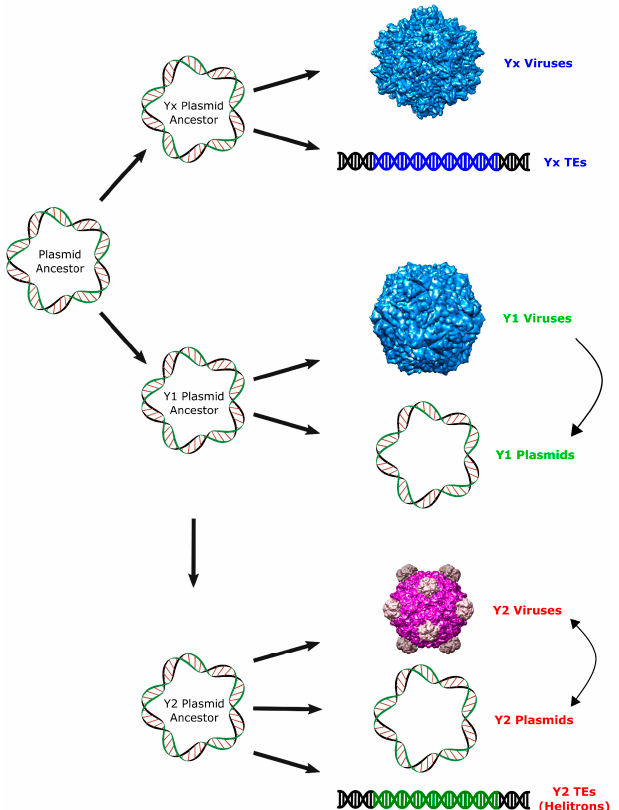
Figure 4. Proposed scenario for the origin of Helitrons and other RCR elements. Arrows represent putative pathways to explain the observed relationship among RCR elements. Virion images were obtained from VIPERdb (http://viperdb.scripps.edu)